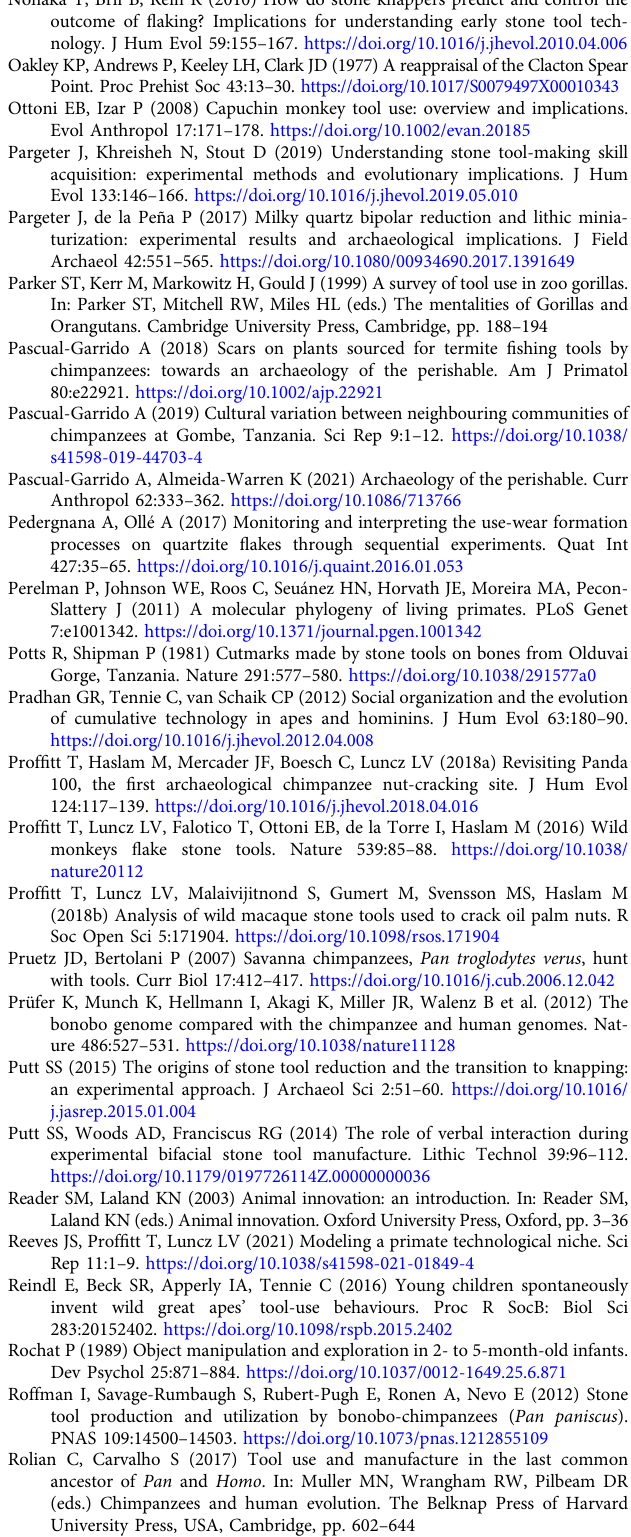
Marks JS, Hall CS (1992) Tool use by bristle-thighed curlews feeding on albatross eggs. Condor 94:1032 – 1034. https://doi.org/10.2307/1369308 Marlowe FW (2005) Hunter-gatherers and human evolution. Evol Anthropol 14:54 – 67.